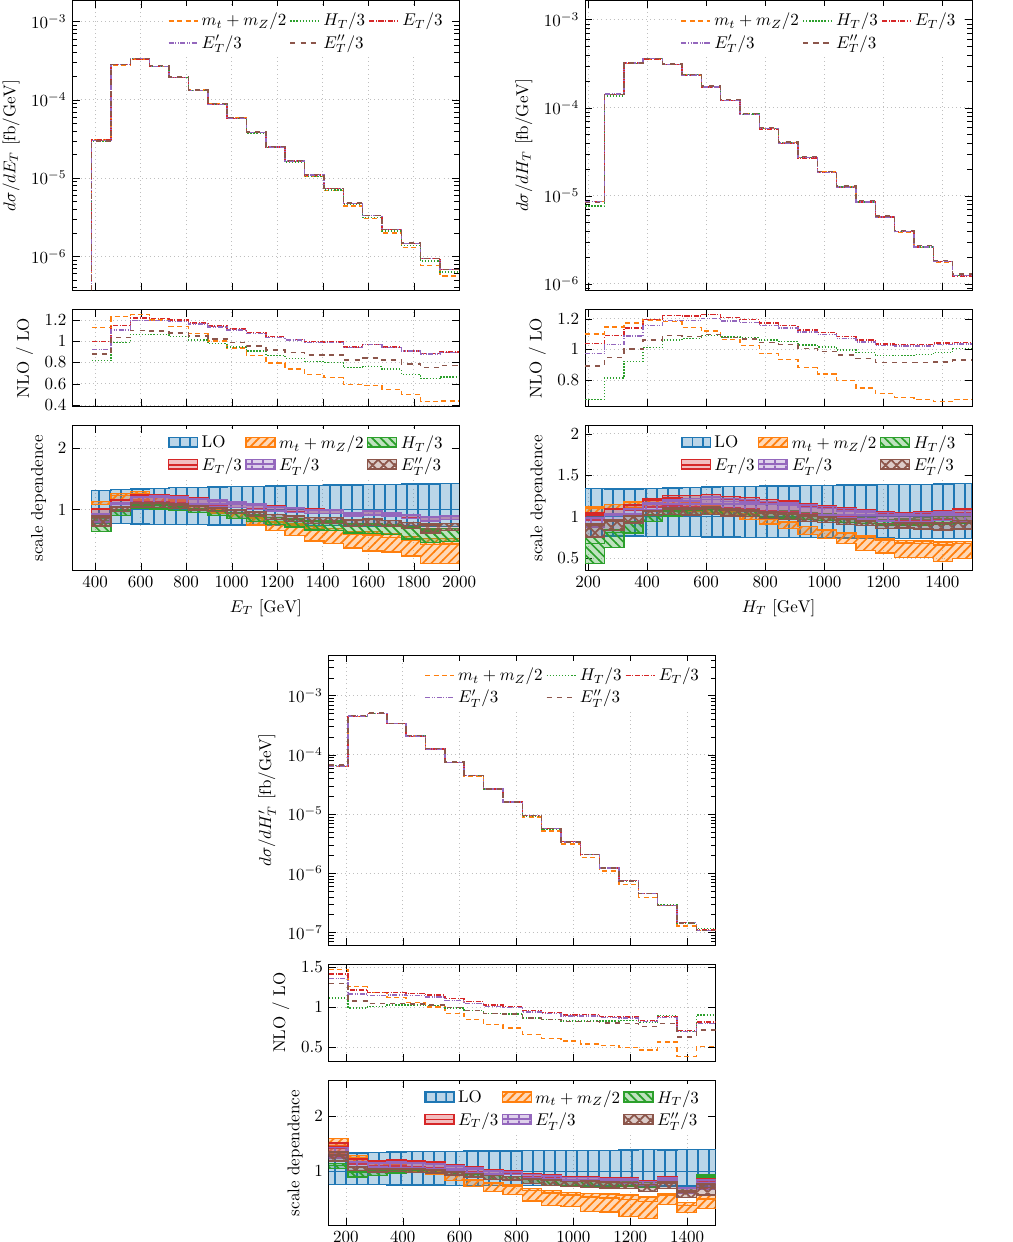
Figure 7 . The pp e + (cid:23) e (cid:22) (cid:0) (cid:22) (cid:23) (cid:22) b (cid:22) b (cid:23) (cid:28) (cid:22) (cid:23) (cid:28) + X di(cid:11)erential cross section distribution as a function of ! E T , H T and H 0 at the LHC run II with p s = 13 TeV. The upper plots show absolute NLO QCD T predictions for various values of (cid:22) 0 where (cid:22) R = (cid:22) F = (cid:22) 0 . The middle panels display di(cid:11)erential factors. The lower panels present di(cid:11)erential factors together with the uncertainty band from K K the scale variation for various values of (cid:22) 0 . Also given is the relative scale uncertainties of the LO cross section for (cid:22) 0 = m t + m Z = 2. The LO and the NLO CT14 PDF sets are employed.